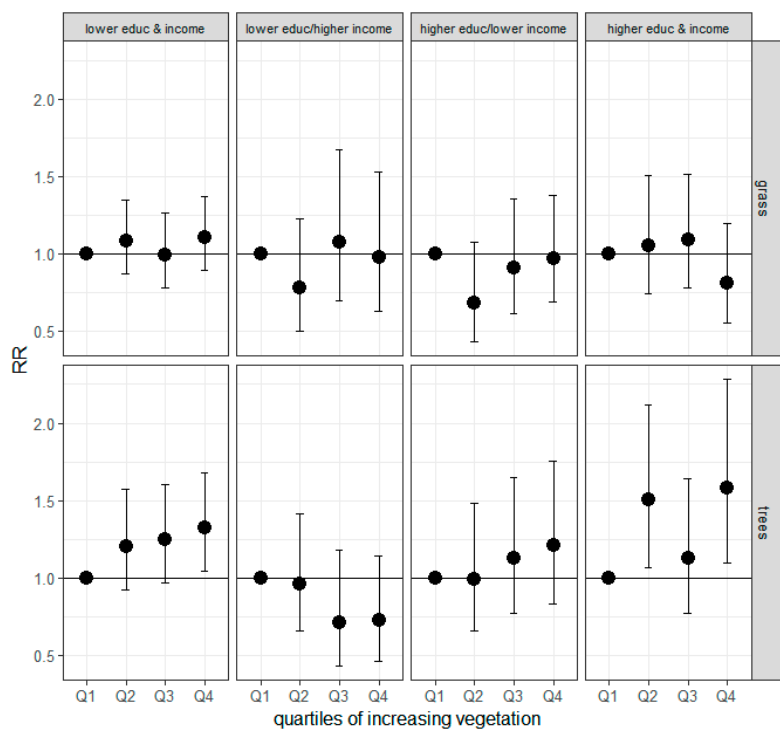
Figure 1. RRs for self-reported “very good” or “excellent” health by quartiles of vegetation density within the 1000 m buffer and SES categories. Models were additionally controlled for season, sampling frame, neighborhood tenure, age, sex, race/ethnicity, individual SES (two-level categorical variable for education, and a six-level categorical variable for income), and area-level SES (% of census tract unemployed and % of census tract living below twice the FPL), RR = relative risk.